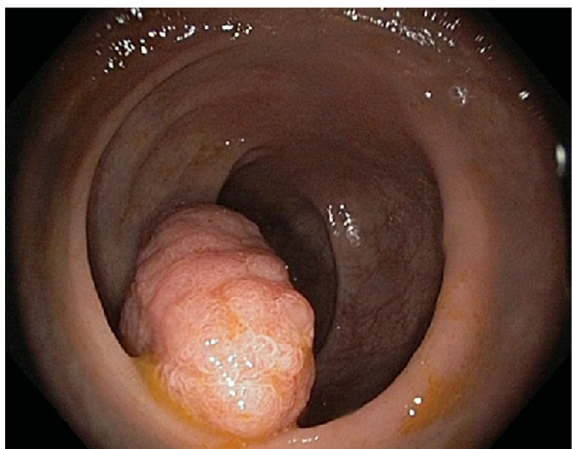
Figure 1. Endoscopic image. The adenomatous polyp immediately before submucosal injection of the EMR composition. The larger dimension of the polyp is about 45